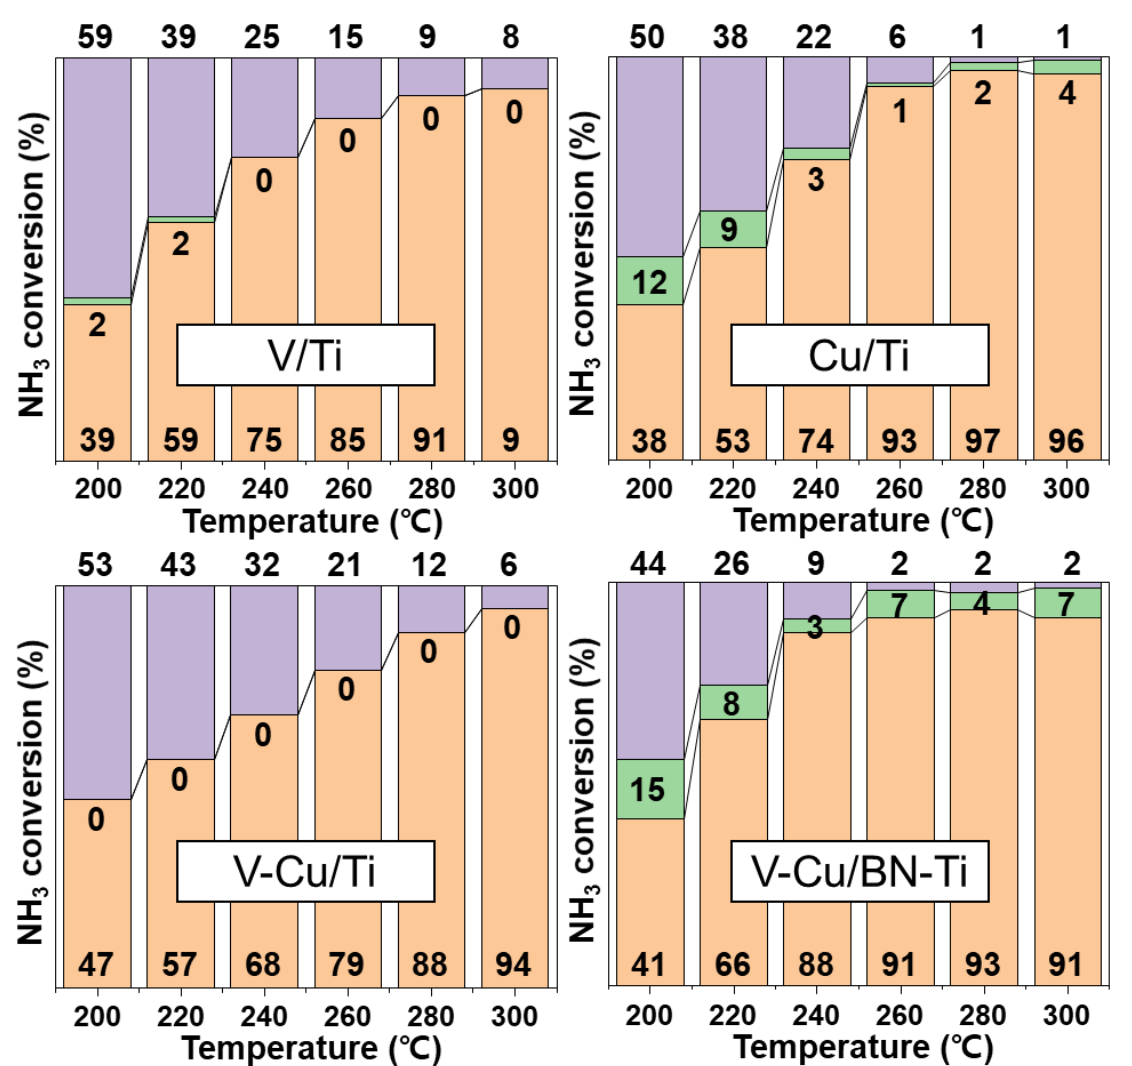
Figure 6. Slipped NH 3 oxidation performance during NH 3 conversion by the synthesized catalysts, calculated using Equation (11). NH 3 -SCR, orange bar; NH 3 -SCO, green bar; and NH 3 -Slip, purple bar. Gas conditions were [NO X ] = [NH 3 ] = 300 ppm, [O 2 ] = 5 vol. %, [N 2 ] = balance, total flow = 500 mL/min, and GHSV = 60,000 h − 1 .